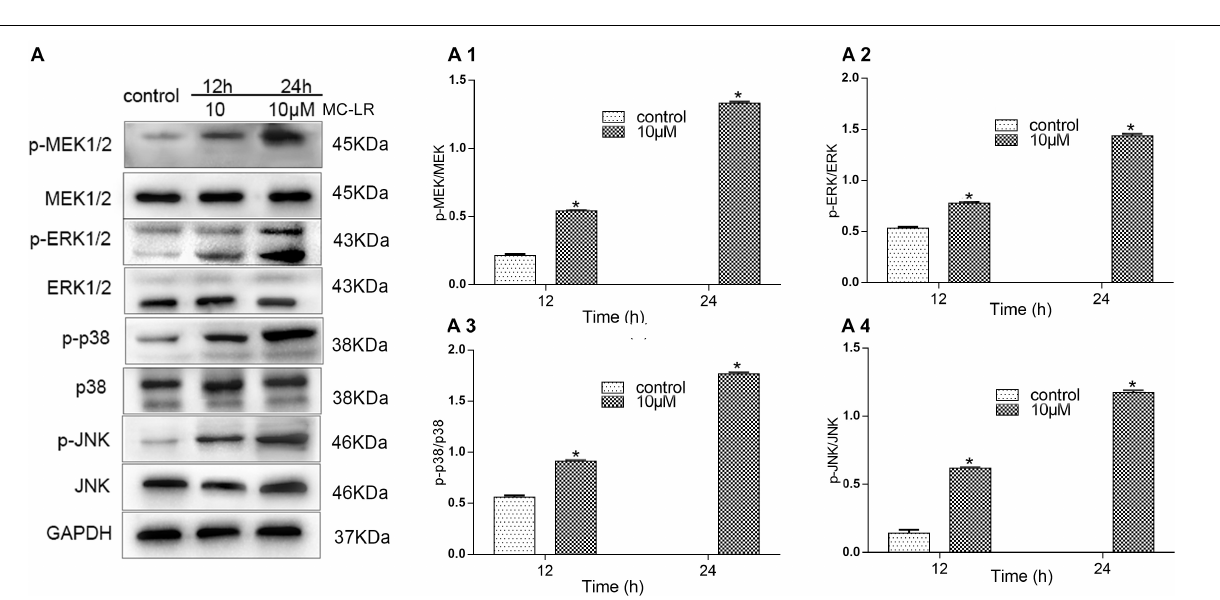
FIGURE 7 | MC-LR and HBx (cid:49) 32 activate the MAPK signaling pathway. The HBx (cid:49) 32 cells were incubated with 10 µ M MC-LR for 12 and 24 h. The protein expression of MAPK was detected by a WB and the representative blots are shown as picture (A) . Bar graphs indicate means ± standard deviation from three independent experiments. Values were obtained by comparing phosphorylated bands with total protein bands, and the results were shown as (A1) Phospho-MEK1/2 (p-MEK) and MEK; (A2) phospho-ERKl/2 (p-ERK) and ERK; (A3) phospho-p38 (p-p38) and p38; (A4) phospho-JNK (p-JNK) and JNK. * P < 0.05 vs. 0 µ M